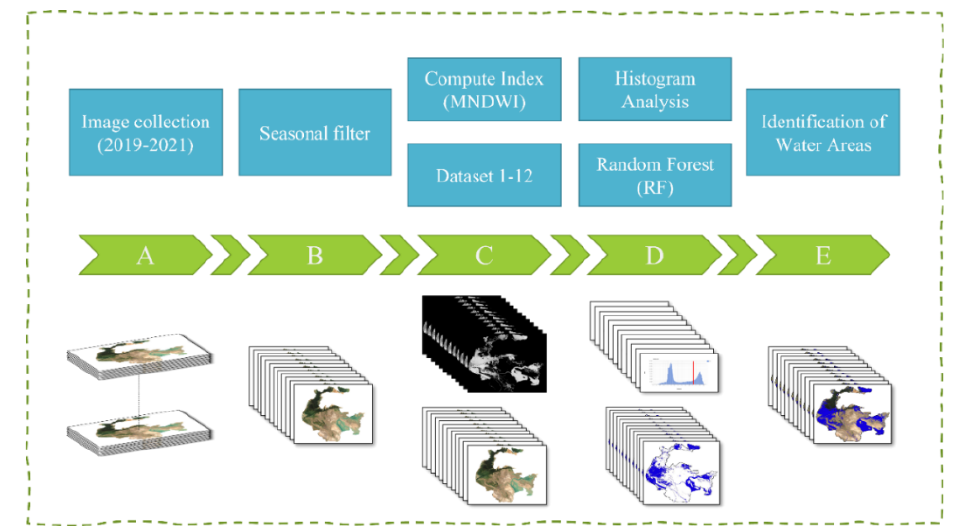
Figure 2. Flowchart of the study of water surface changes ISW in Iran with Google Earth Engine.